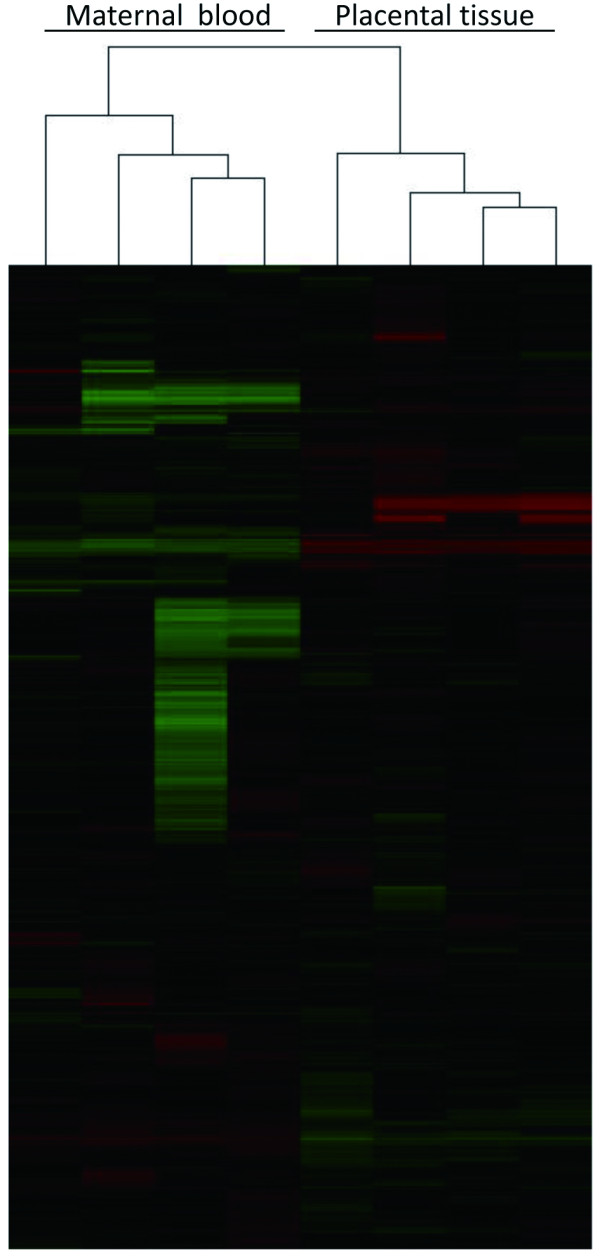
Unsupervised clustering in four pairs of matched placental tissue and maternal peripheral blood samples.